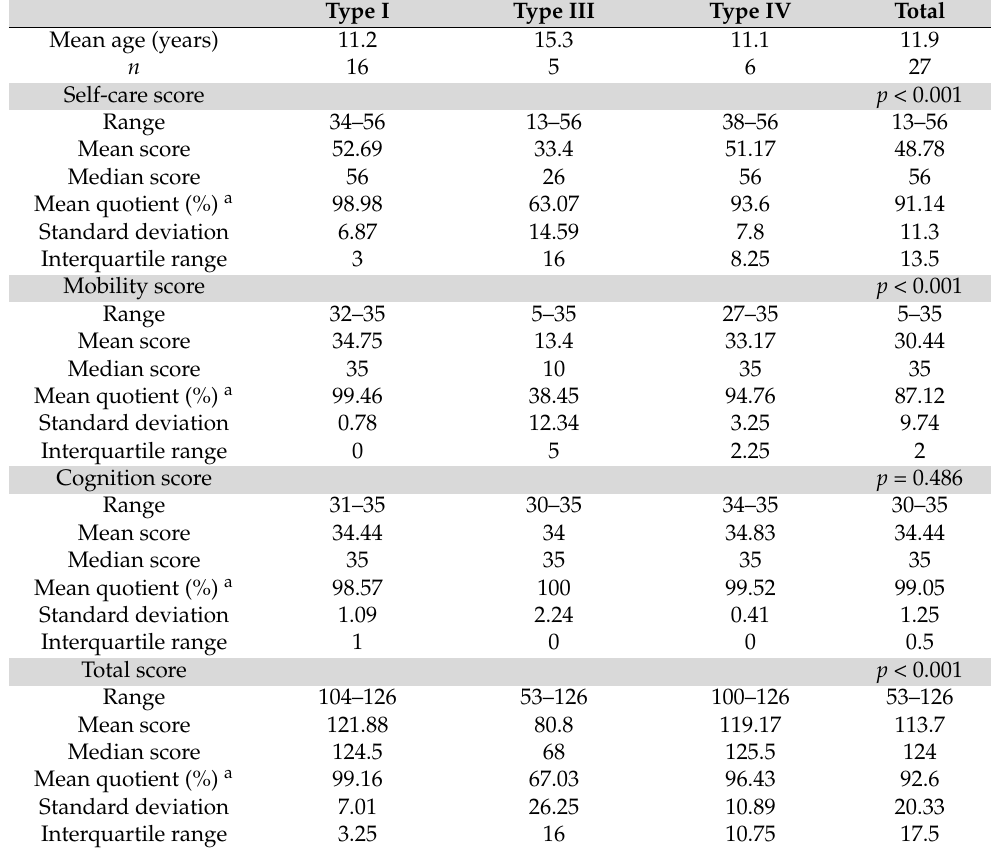
Table 3. WeeFIM scores of the children with osteogenesis imperfecta by disease